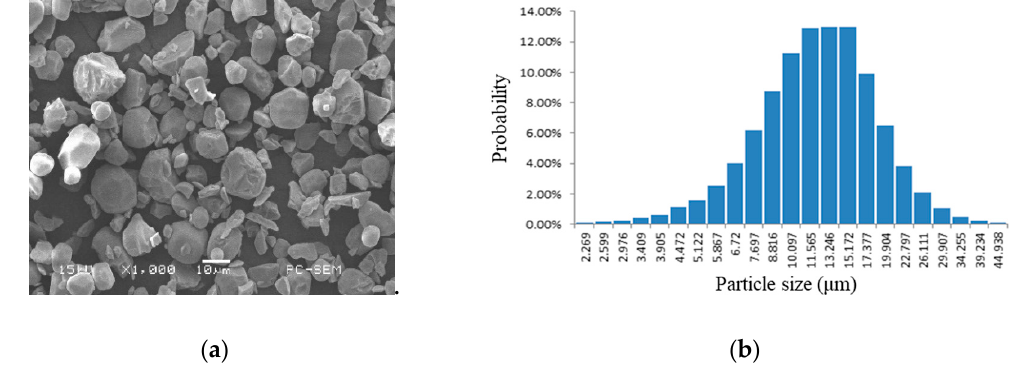
Figure 9. ( a ) SEM image of phosphor particles and ( b ) its diameter distribution.